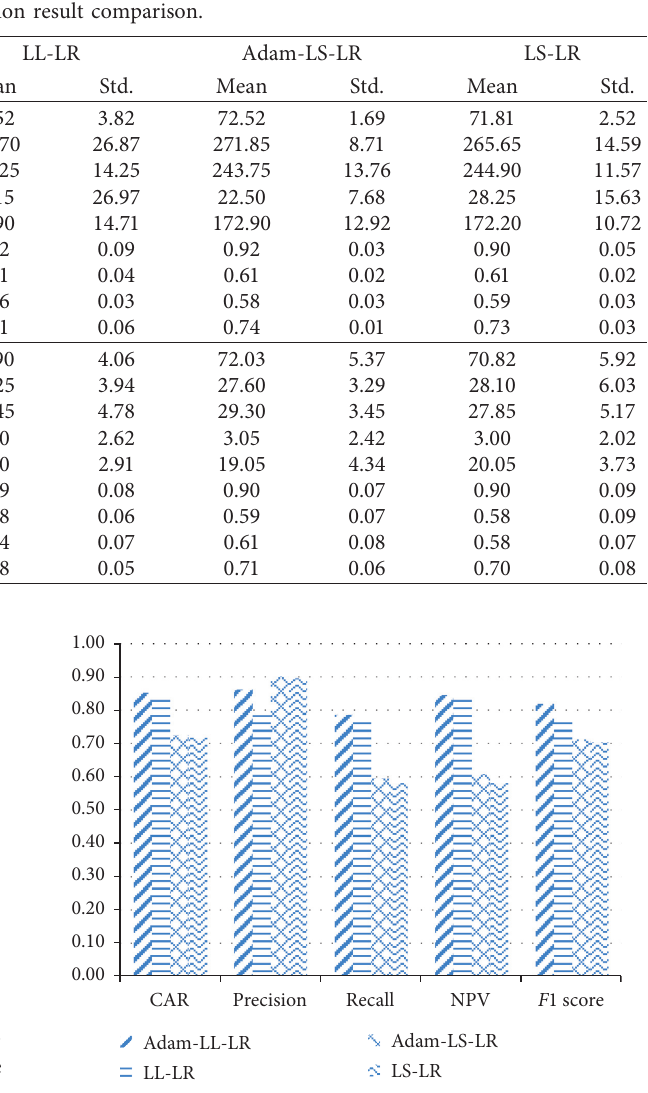
Figure 8: Performance measurement indices for the training